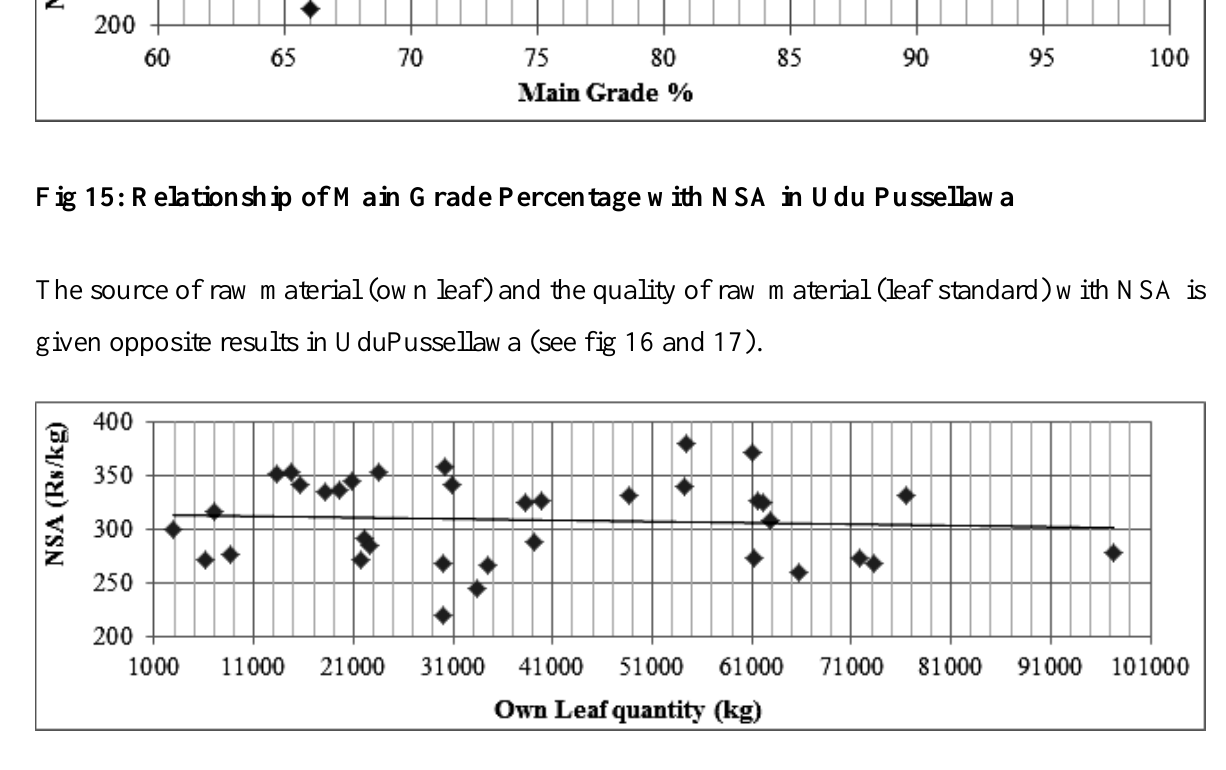
Fig 16: Relationship of Own Leaf Quantity with NSA in Udu Pussellawa Results revealed that there is factor in own leaf affecting the price which has not shown in Nuwara Eliya and Western regions. That is, when comparing the results of main grade percentage, the low quality in own leaf can be the reason. In the situation of best leaf standard, negative results denote that some external demand factors are influencing the price determination because low prices have obtained for high percentage of main grades produced with high quality raw